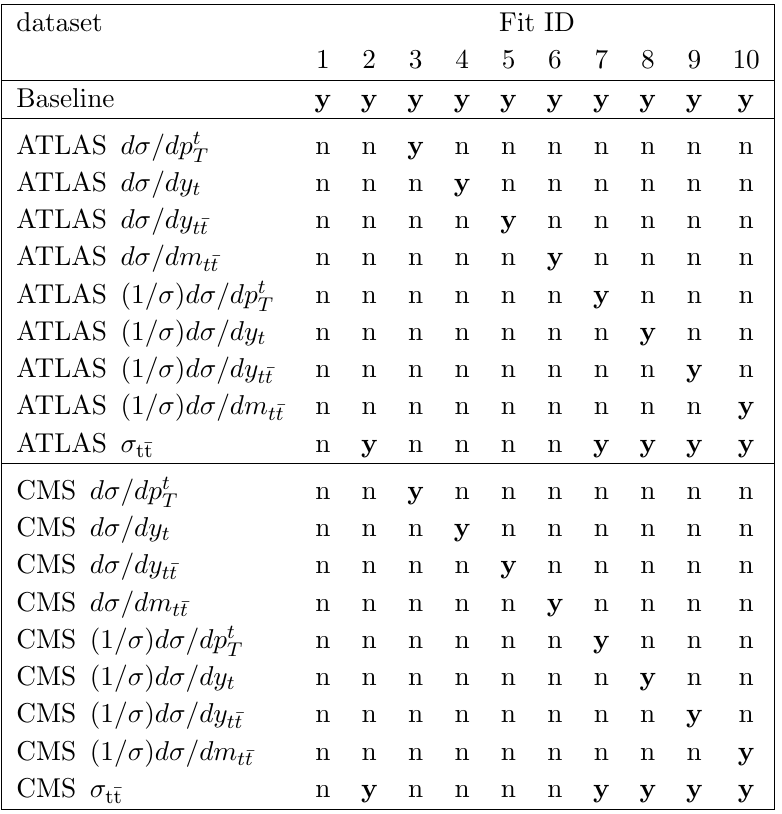
Table 5 . Overview of the (cid:12)ts presented in this work. The baseline dataset is composed by either the HERA structure functions or by the NNPDF3.0-like dataset (see text). For each (cid:12)t, we indicate in boldface which top-quark pair measurement from ATLAS and CMS have been